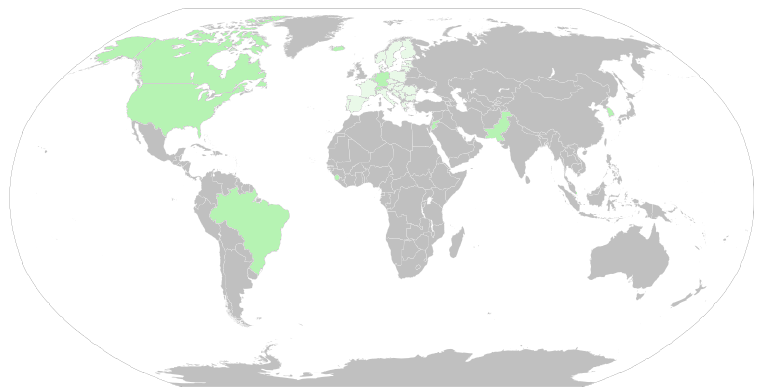
Figure 5. Overview of the selected countries for the SSI